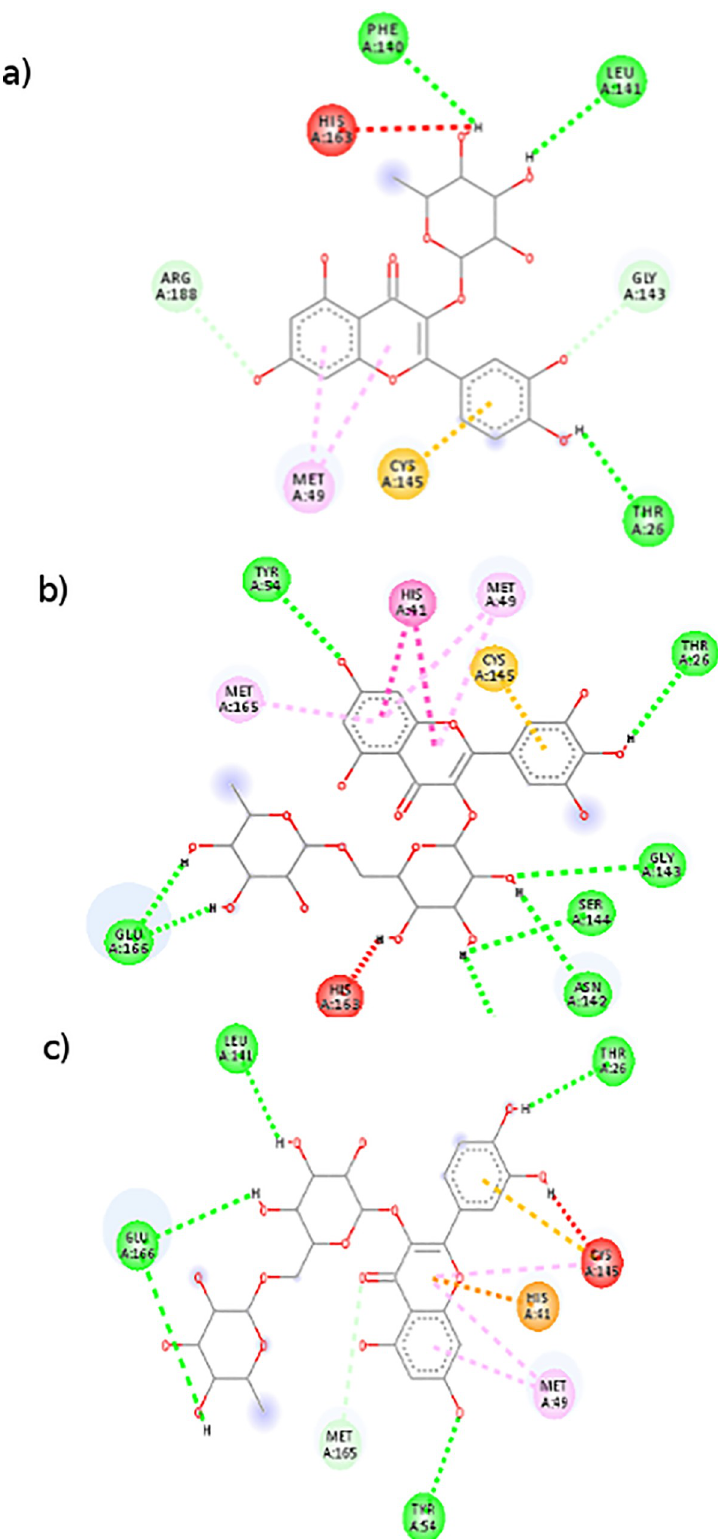
Fig 5. Interaction of flavonoids at the active site of the SARS-CoV-2Mpro a) Quercetin -3 Rhamnose, b) Myricetin 3-rutinoside, c) Rutin. https://doi.org/10.1371/journal.pone.0240653.g005 PLOS ONE | https://doi.org/10.1371/journal.pone.0240653 October 15,